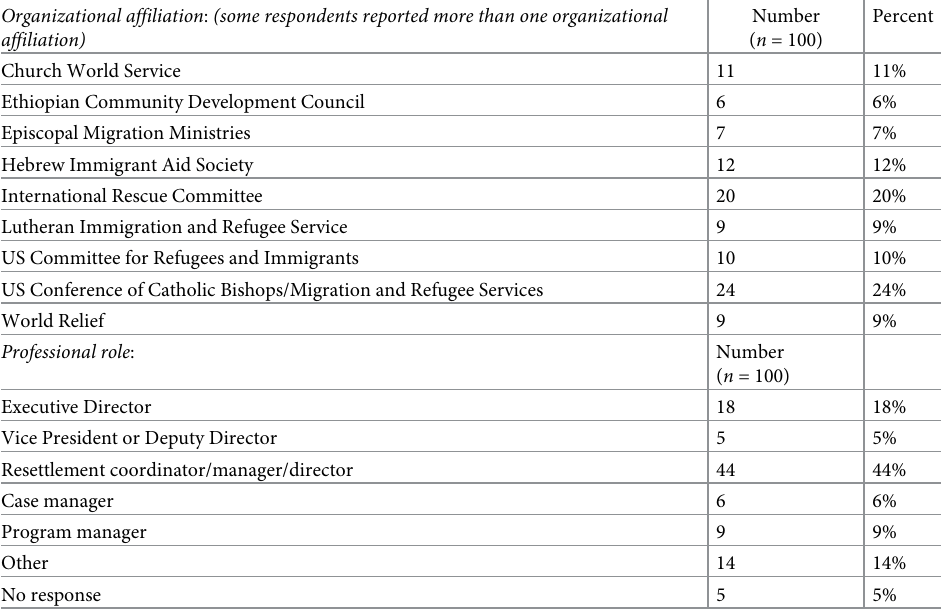
Table 1. Respondent